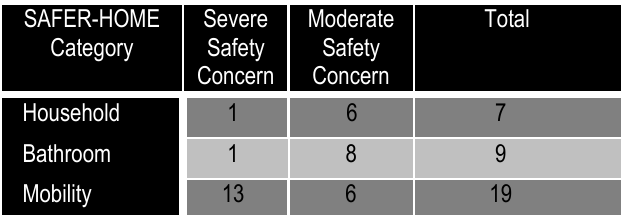
Table 5. SAFER HOME v.3 Categories with Largest Moderate and Sever Safety